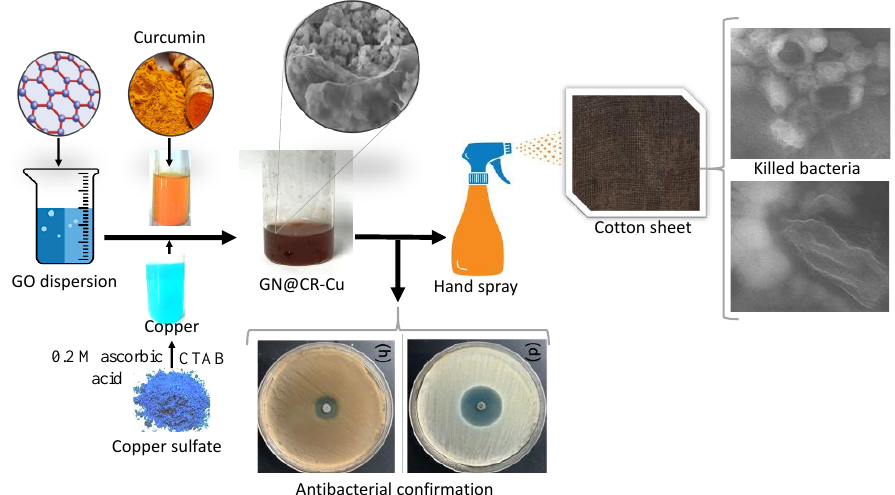
Figure 1. Schematic representation of the synthesis and antibacterial application of GN@CR-Cu.